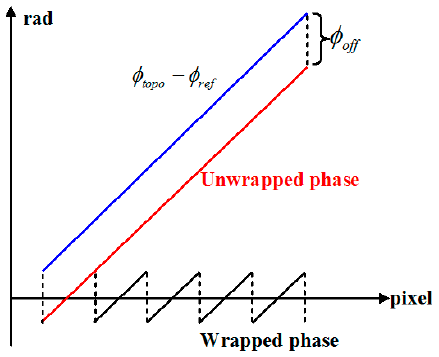
Figure 2. Absolute phase offset calibration.